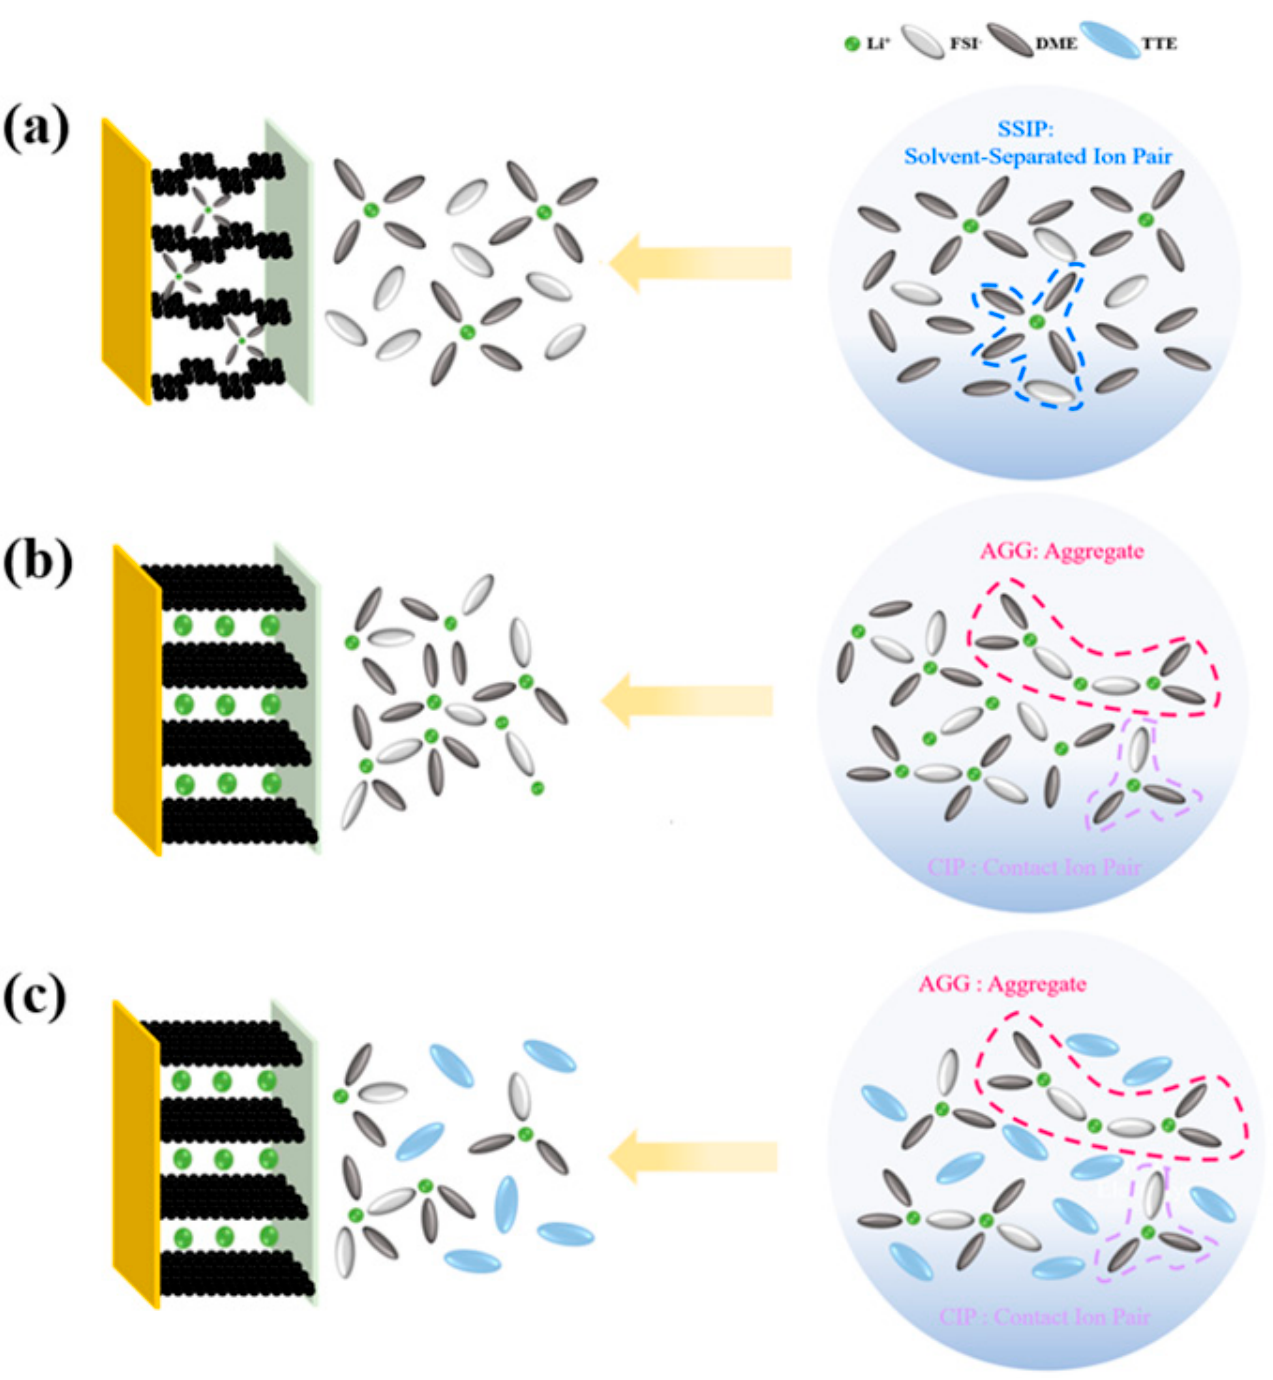
Figure 11. Schematic illustration of Li + embedded graphite layer in ( a ) LCE, ( b ) HCE, ( c )